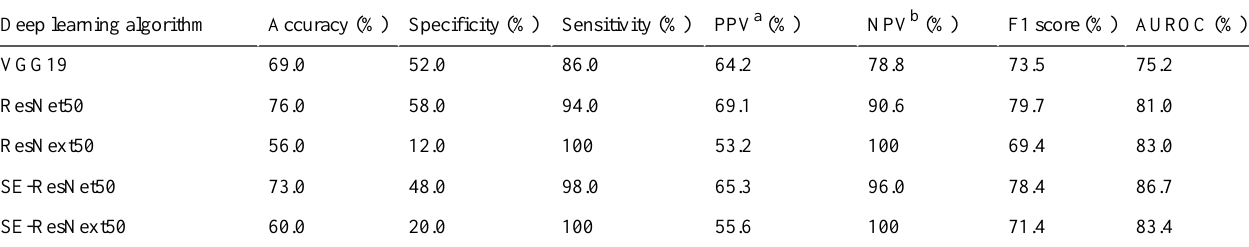
Table 3. Thyroid classification results with federated learning with external test